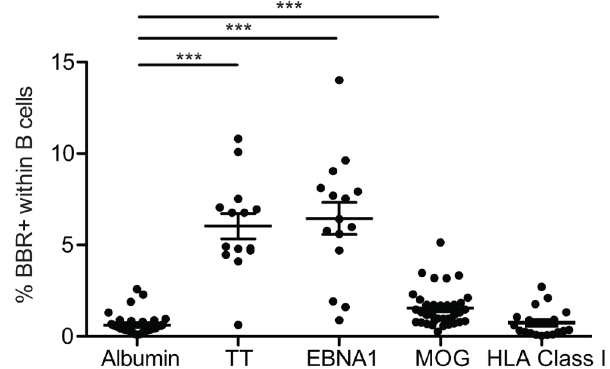
Figure 3. B cells from healthy volunteers exhibit a broad range of reactivity. Purified B cells from healthy volunteers were tested for their reactivity to albumin (n=38), Tetanus Toxin (n=14), EBNA1 (n=15), MOG 1–125 (n=38) and a panel of 97 HLA class I molecules (n=19). ***p , 0.001 (Kruskall-Wallis follow by a Dunn’s post hoc test using albumin settings as reference group).